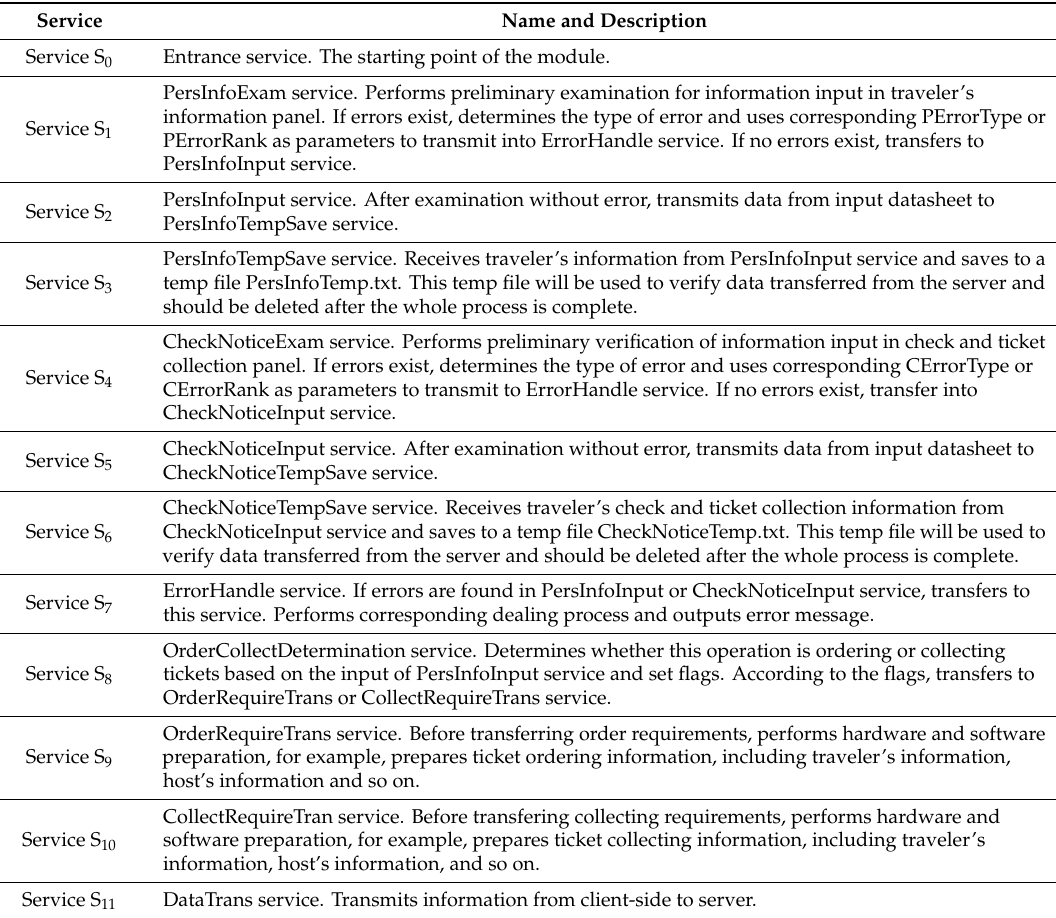
Table A1. Name and description of each service in client-side information reception module.